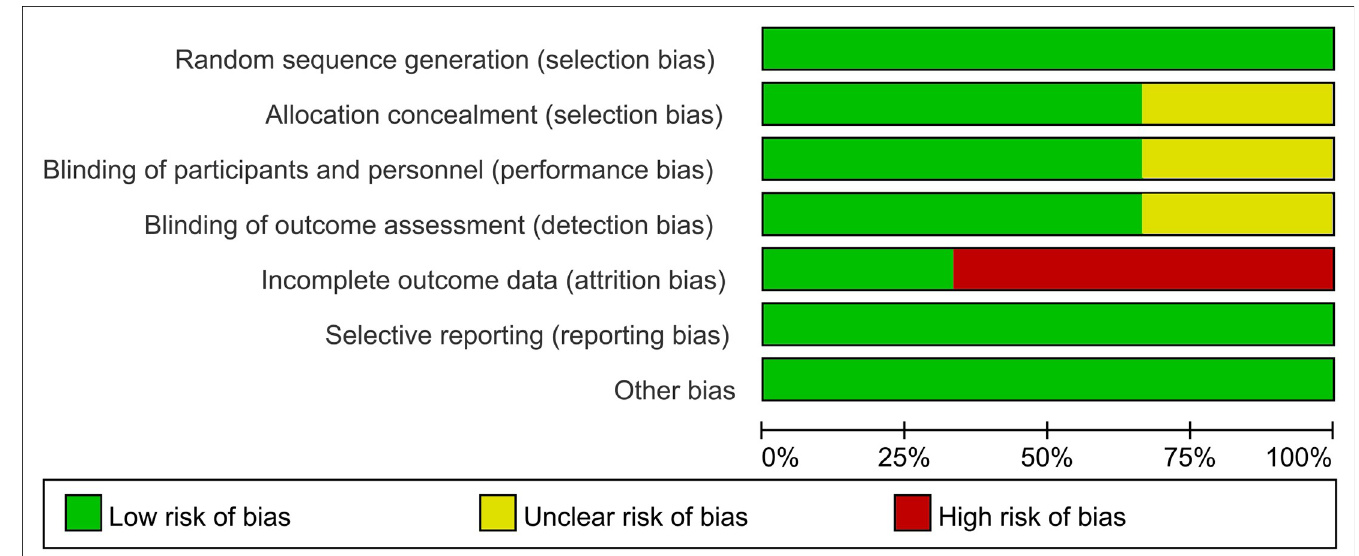
Fig 2. Diagram of the risk of bias in the included studies.